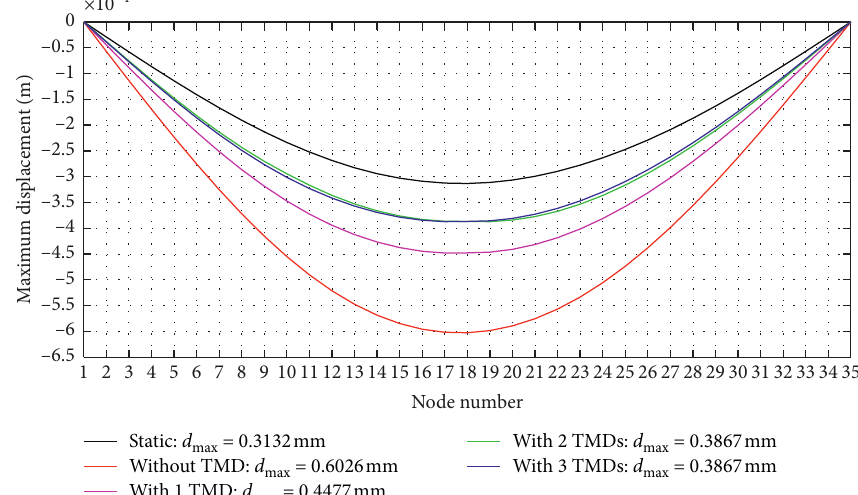
Figure 12: Maximum vertical displacement for each node of the bridge, for static case (black curve), dynamic without TMD (red curve), with 1 TMD (magenta curve), with 2 TMDs (green curve), and with 3 TMDs (blue curve), for a truck velocity of 50km/h.